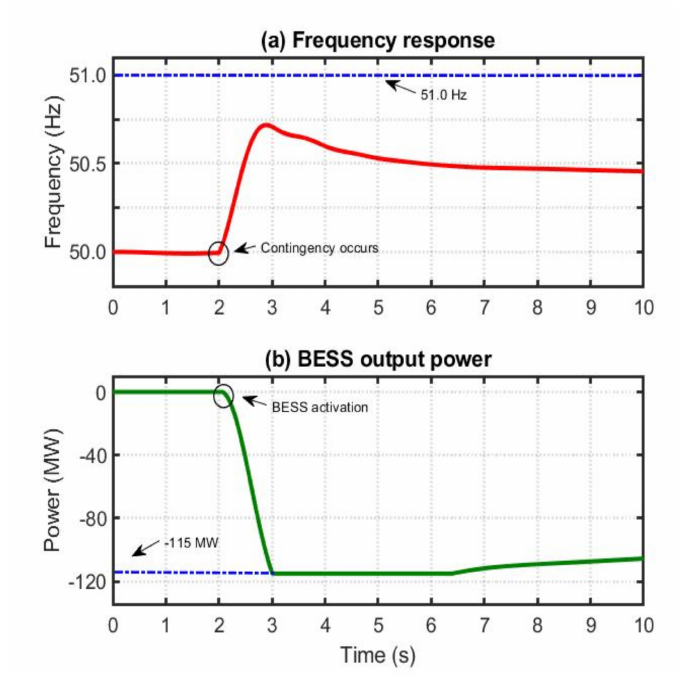
Figure 8. Frequency responses and BESS output due to 400-MW interconnection trip in five-machine case.